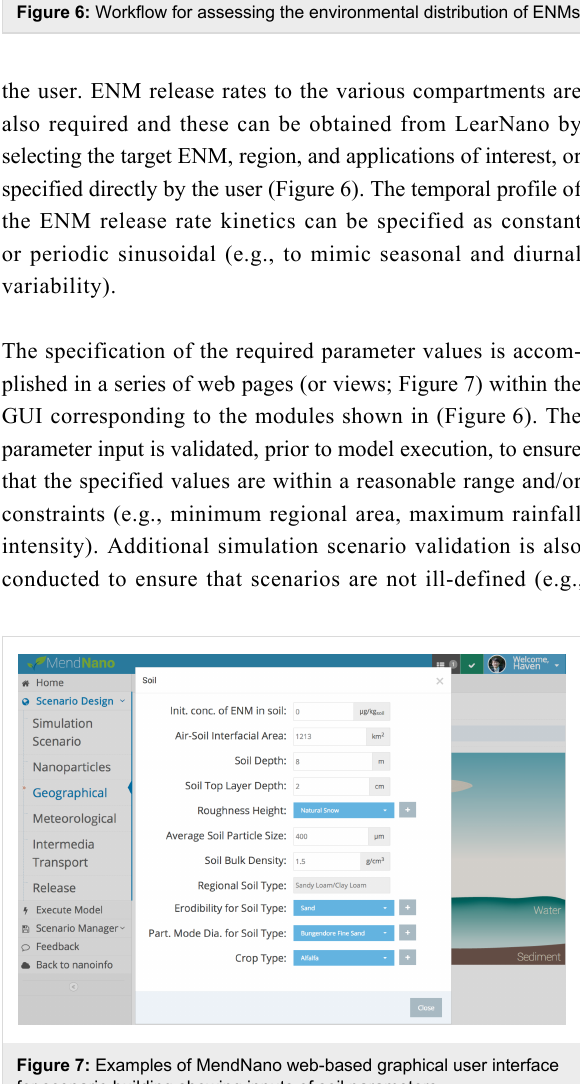
Figure 6: Workflow for assessing the environmental distribution of ENMs. ITP: intermedia transport processes, PSD: particle size distribution.